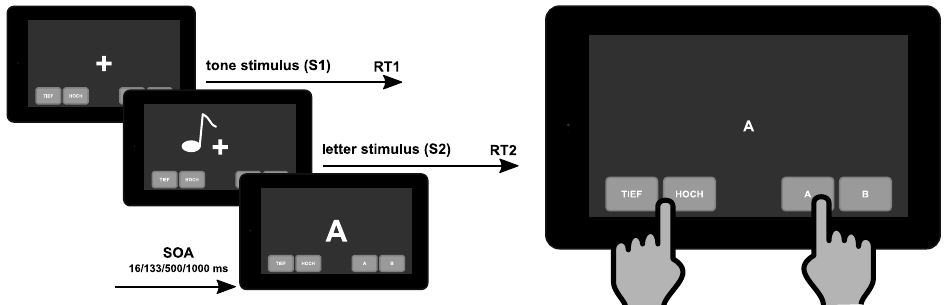
Figure 1. Schematical illustration of the psychological refractory period (PRP) paradigm. The tone stimulus (S1) is presented first. The letter stimulus (S2) is presented with a defined stimulus-onset asynchrony (SOA). Participants are asked to respond as soon as possible to the tone stimulus by pressing one of two buttons with their left index finger and to respond as fast as possible to the letter stimulus by pressing one of two buttons with their right index finger.